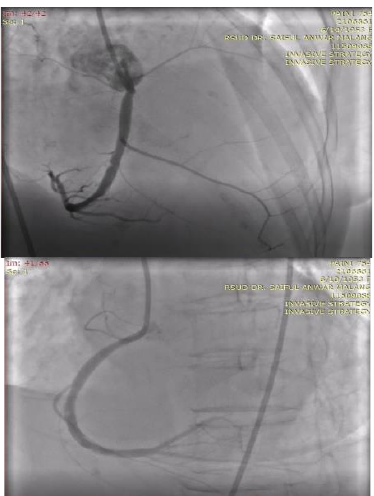
Figure 4 . Coronary angiogram showed thrombus and ste- nosis 50% in the distal right coronary